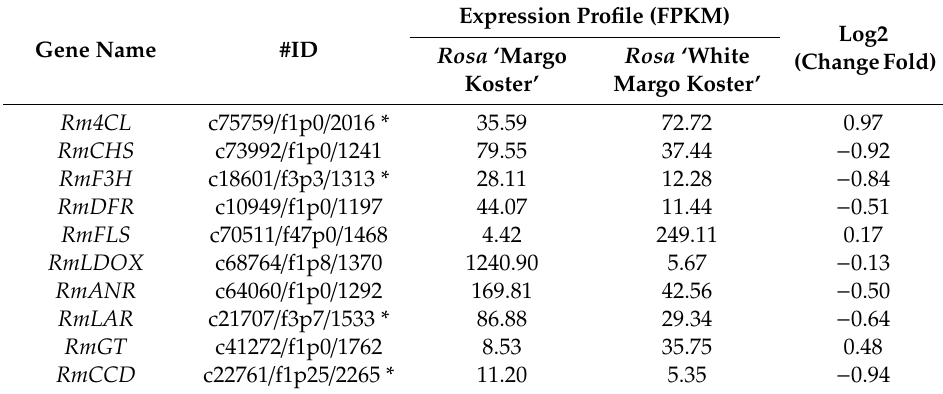
Table 4. FPKM (Fragments Per Kilobase Million) of key genes involved in flavonoids and associated biosynthesis in the petals of rose